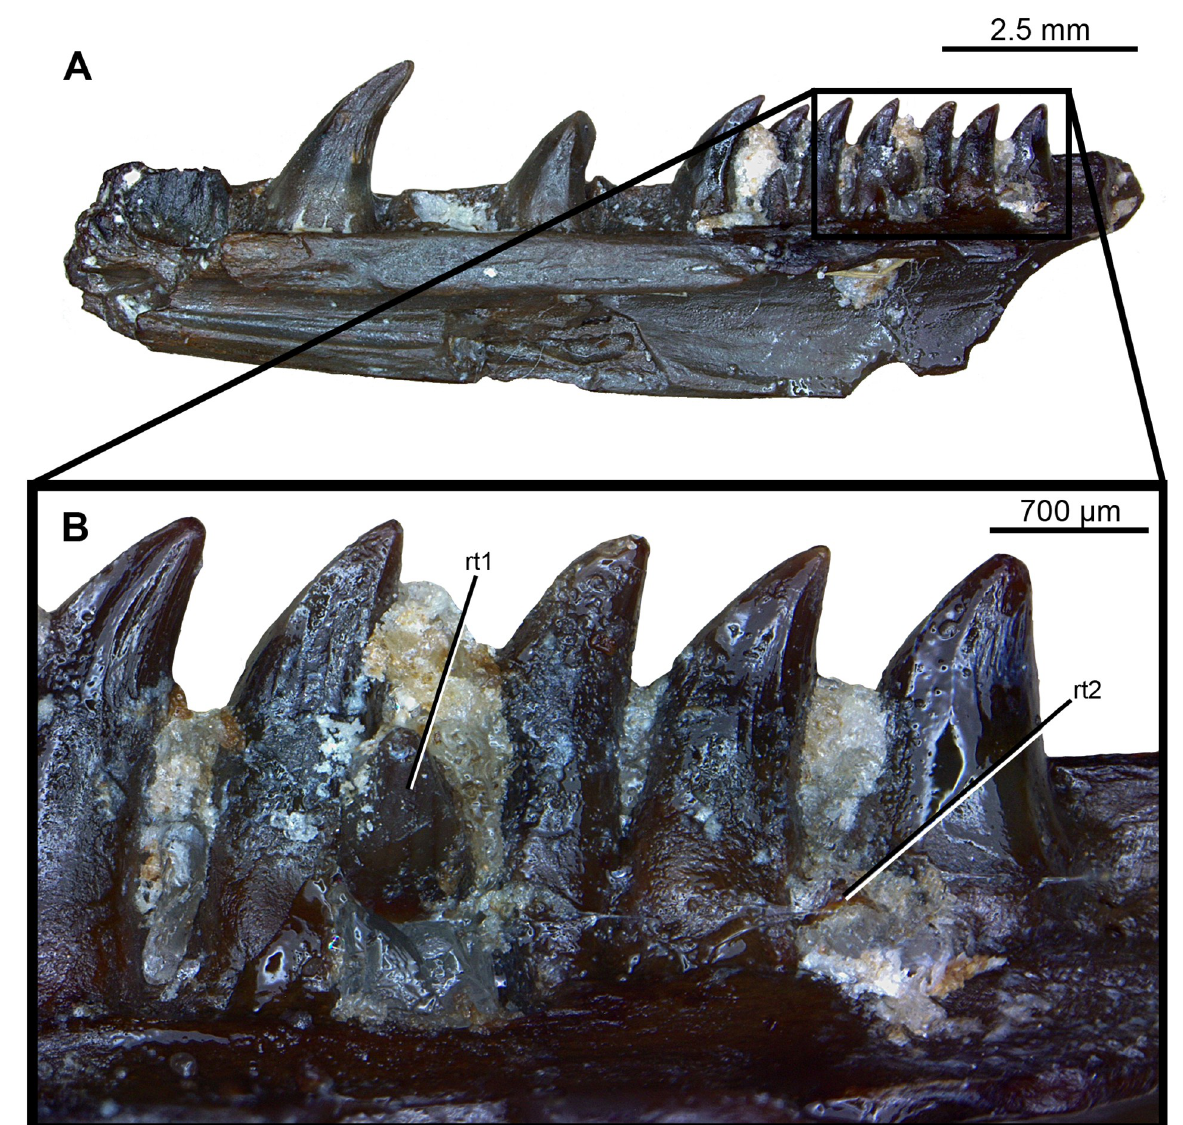
Fig 10. Photograph of replacement teeth in positions for Maiothisavros dianeae (ROMVP 87369). Right dentary in (A) lingual view and (B) close-up of two replacement teeth. Abbreviations: rt; replacement tooth.